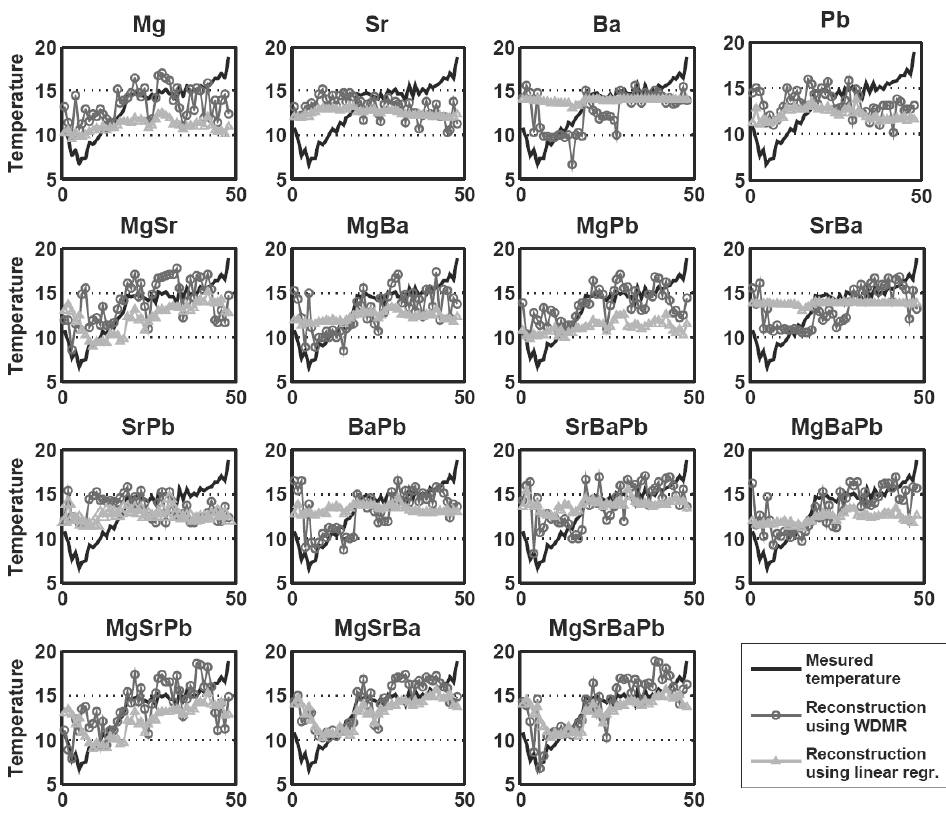
Fig. 4. Detailed visualization of the temperature reconstructions for the shell from the Knokke study site for all proxy combinations, the x-axis corresponds with sample number along the along the shell’s growth axis.